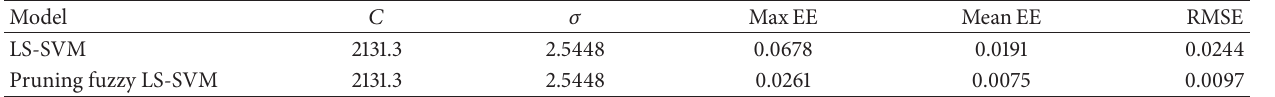
Table 3: The predicted concentration of penicillin.